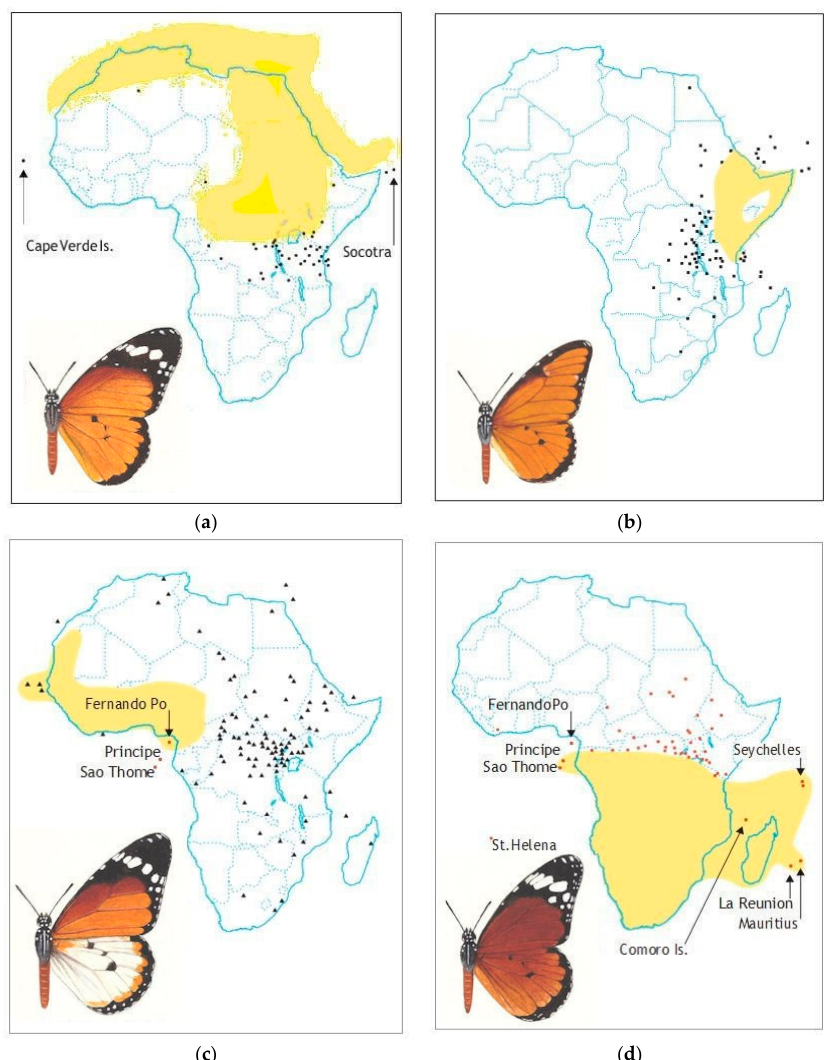
Figure 2. Geographical distribution of the subspecies (ssp.) of Danaus chrysippus in Africa. ( a )